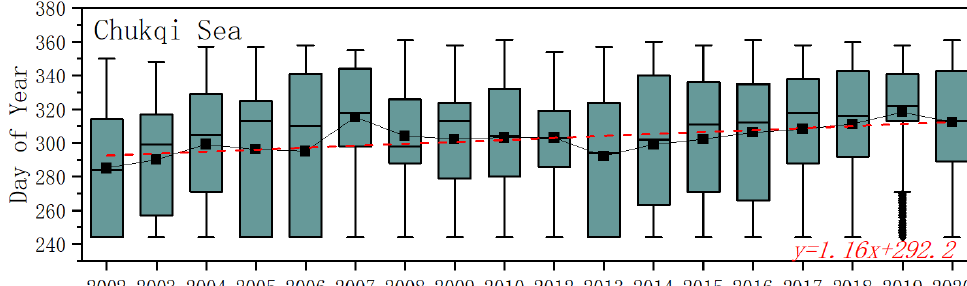
Figure 17. Temporal series analysis of sea ice freeze-up dates in the Kara Sea, Laptev Sea, East Siberian Sea, and Chukchi Sea in the Arctic from 2002 to 2020, which shows an obviously postponed trend for freeze-up for all the selected seas. The standard errors were 0.48, 0.36, 0.45, and 0.28, respectively, and passed the significance test ( p < 0.05).